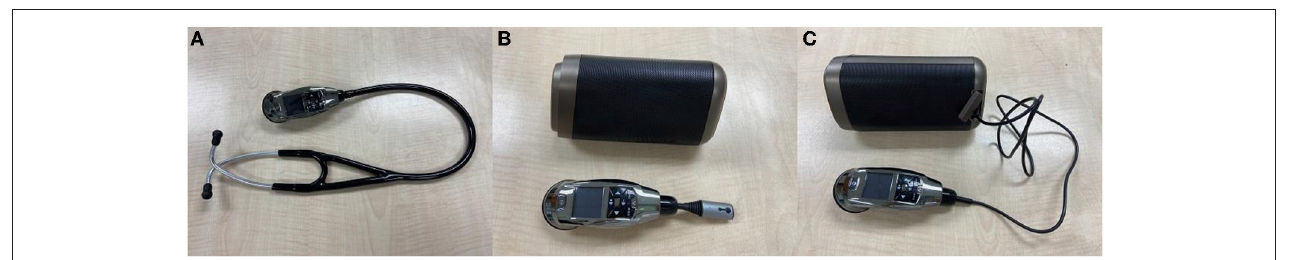
FIGURE 2 | Patient